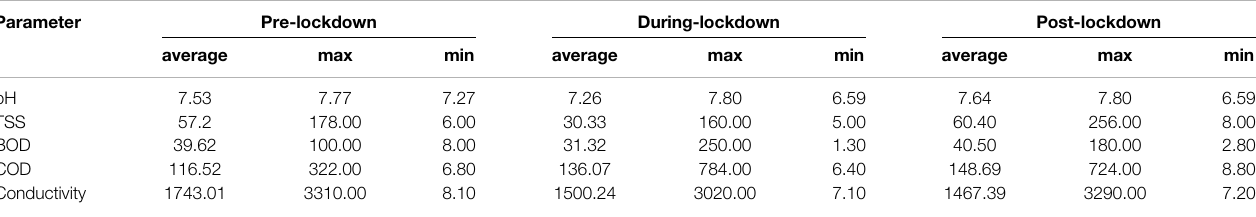
TABLE 2 | Mean, maximum and minimum values of water quality variables determined in the pre-lockdown, during the lockdown, and post-lockdown periods. Parameter Pre-lockdown